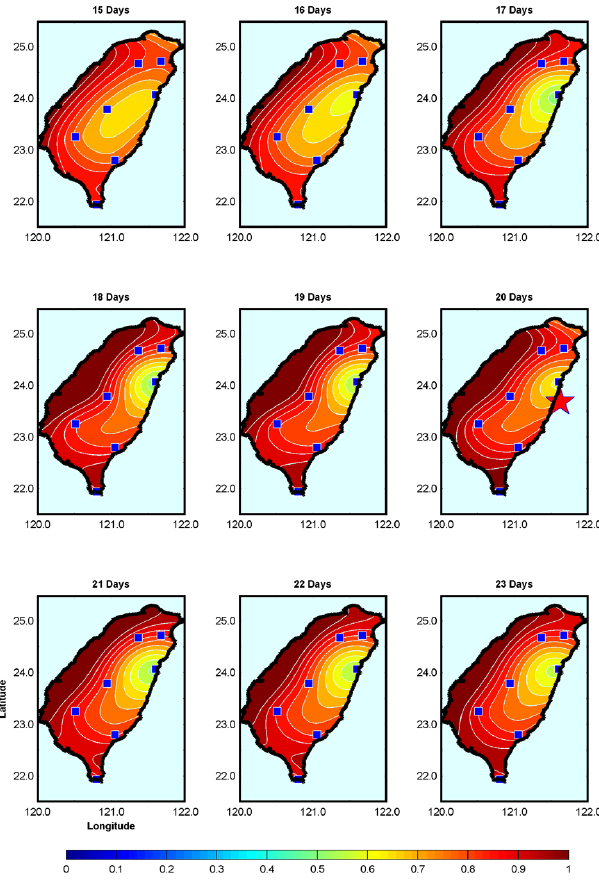
Fig. 4. The cross correlation values at the 8 stations and Dst from 1 September 2010 to 17 March 2011. Shadow and black lines denote the cross correlation values derived from the daytime and nighttime data.